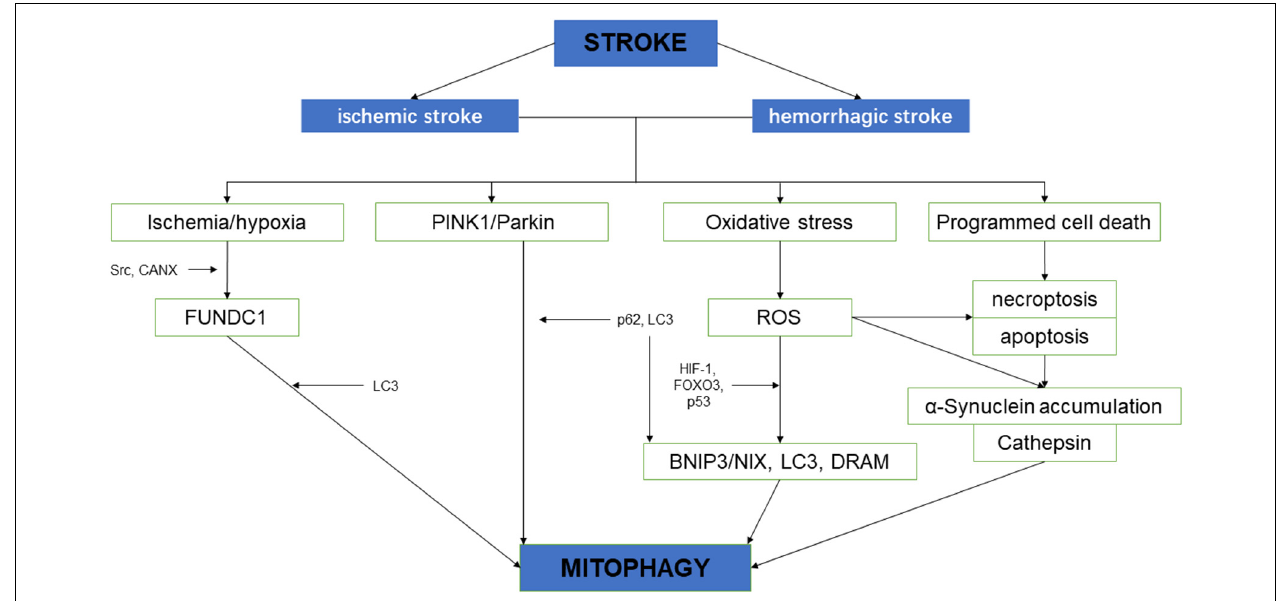
FIGURE 2 | The schematic diagram depicting the relationship between cerebral stroke and mitochondrial